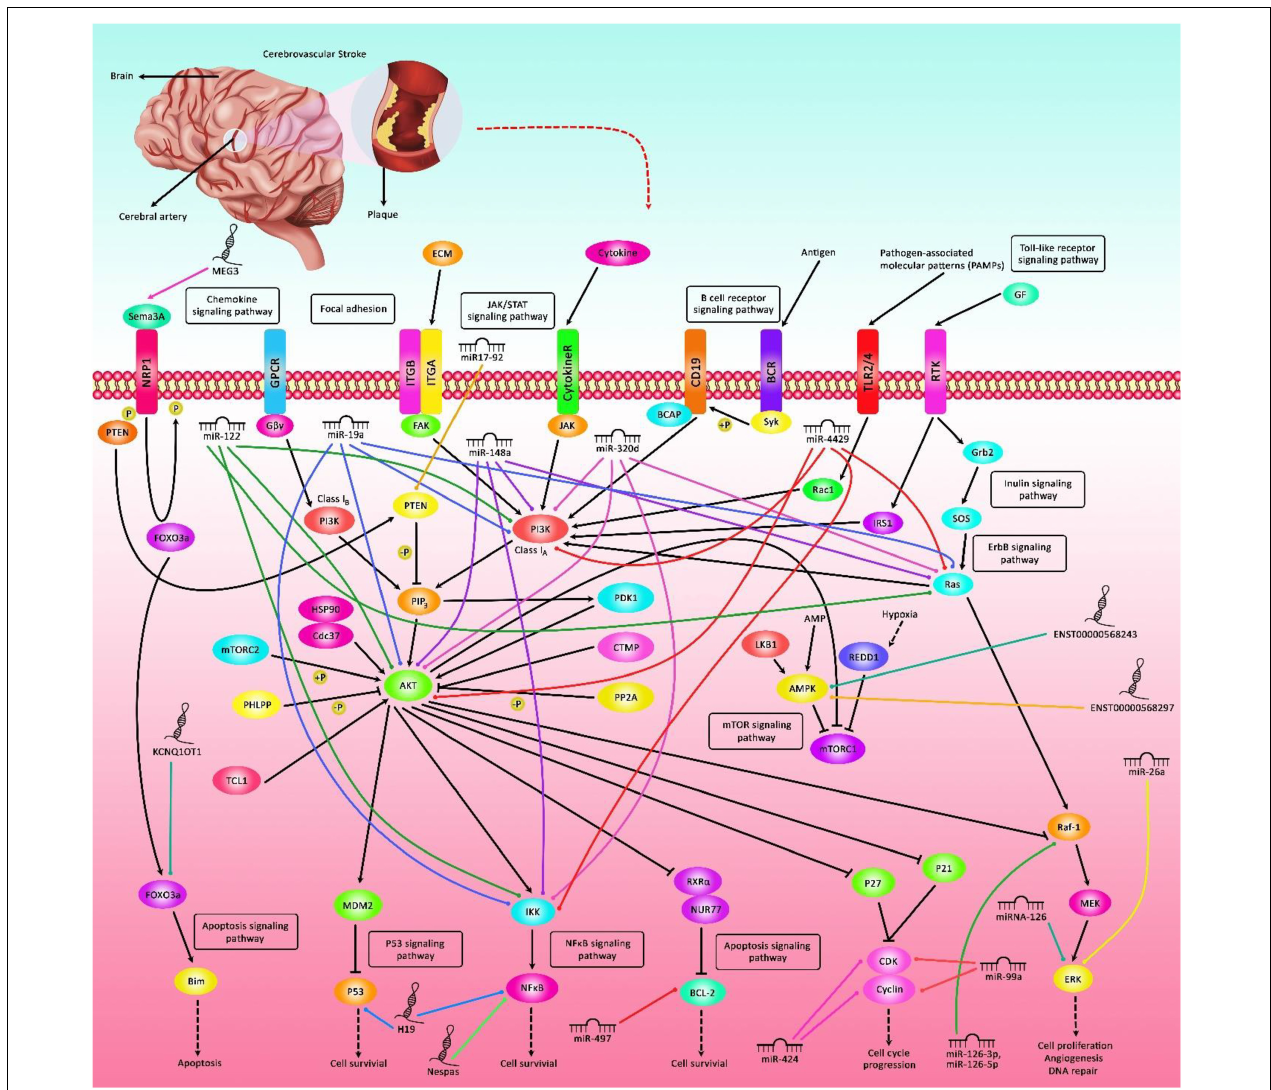
FIGURE 1 | A schematic representation of the interaction between non-coding RNAs and various signaling cascades in ischemic stroke (IS). Differential expression of lncRNAs as well as miRNAs could have an important role in the pathogenesis of IS. Various miRNAs such as miR-19a, miR-122, miR-148a, miR-320d, and miR-4429 via targeting Akt, PI3K, Ras, and IKK could modulate expression of genes leukocytes, thus affecting the course of IS. In addition, miR-497 by regulating the expression levels of Bcl-2 and Bcl-w could induce ischemic neuronal death. Additionally, lncRNA H19 via directly targeting P53 could suppress neurogenesis following IS through p53/Notch1 axis. Furthermore, MEG3 could promote cell survival and reduce cell apoptosis via modulating the expression of Sema3A. Besides, KCNQ1OT1 through modulating the expression of FOXO3 could enhance brain injury and induce autophagy in IS.